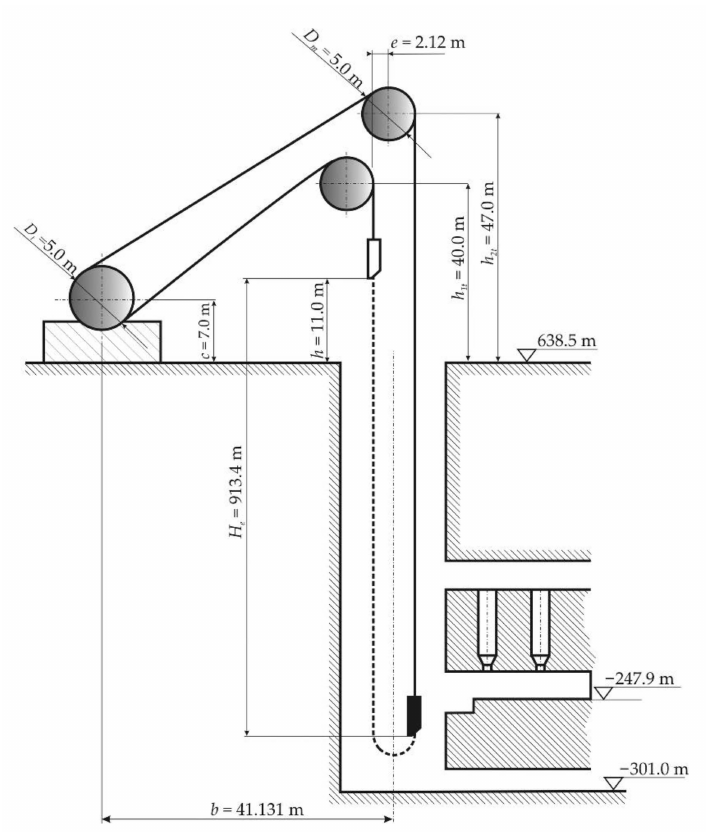
Figure 1. General layout of a friction mine hoist [3]. The brake systems used in Romanian MK5 × 2 model friction hoisting machines are of the drum-and-shoe type [4], as shown in Figure 2a. This type of brake consists of a drum lining placed on each side of the rope wheel circumference, and two pairs of brake shoes lined with friction material, situated on the drum lining diametrically opposite, together with a series of springs and levers that are actuating the brake, as shown schematically in Figure 2b. The features of the MK5 × 2 mine hoist drum brake system are described in the technical documentation from the manufacturer [5]. These features are presented in Table 1 and were used to create the 1:1 scale geometric model, built as described in Section 4.